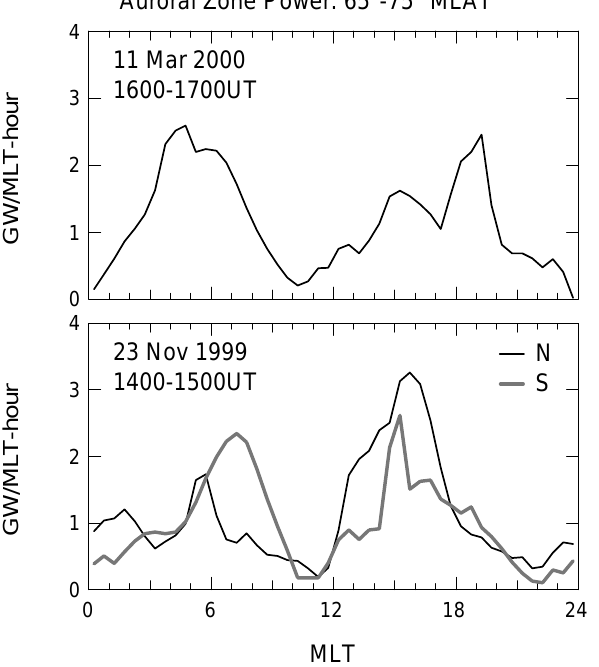
Fig. 8. Cumulative power integrated over local time in 2 ◦ MLAT bins versus magnetic latitude for (top) 11 March 2000 and (bottom) 23 November